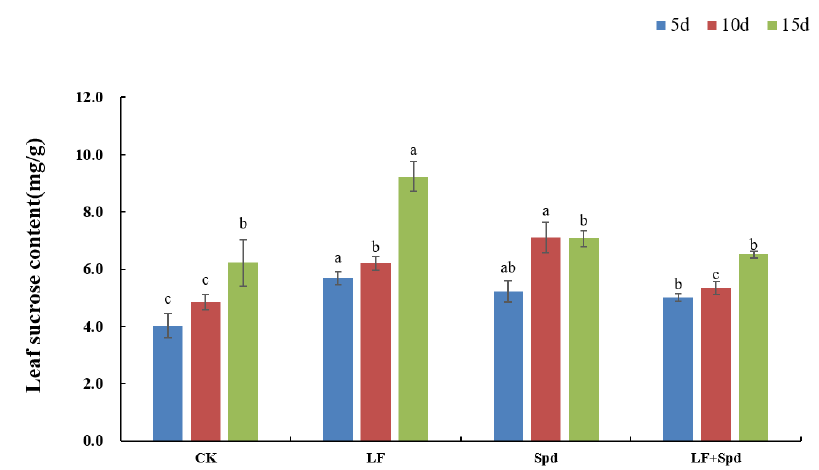
Figure 12. Effects of exogenous Spd on the sucrose content in tomato leaves under low-iron stress. Means denoted by the different lowercase letters on the same color bars are significantly different according to Duncan’s multiple range test ( p ≤ 0.05); the mean represents the average of three replicates and the vertical bar indicates ± standard deviation (SD).